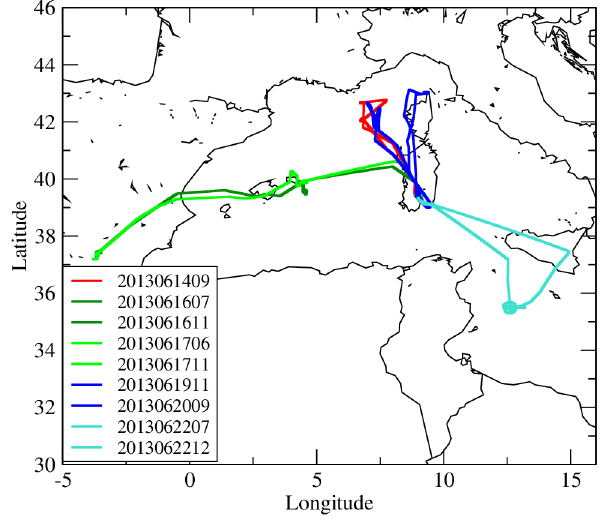
Figure 3. ATR-42 horizontal trajectories for the flights of 14 (red), 16 and 17 (blue), 19 and 20 (green) and 22 June (green-blue).